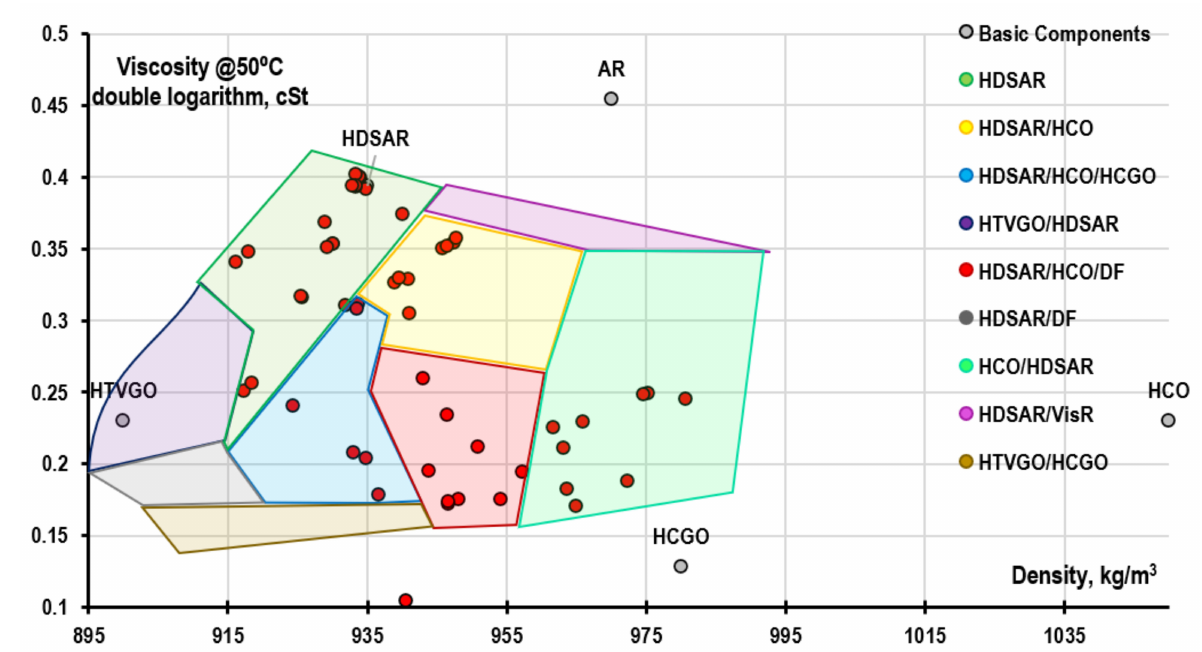
Figure 21. Lots of North American ports in logarithmic coordinates [87]. Table 12. Distribution of shipments of North American ports by type